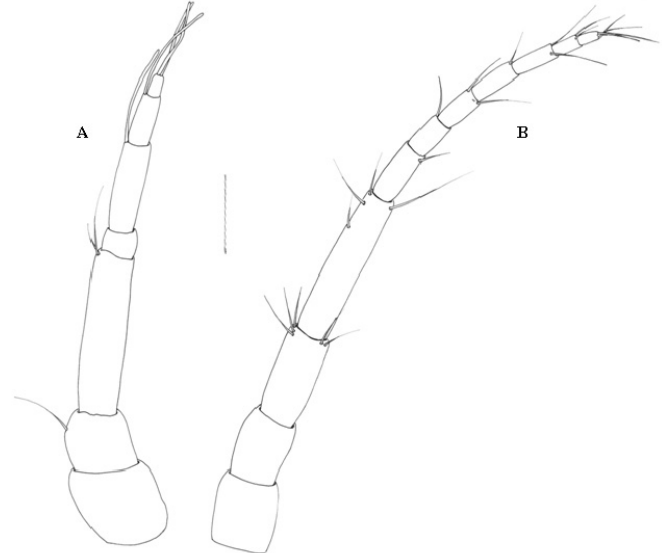
Fig. 3 – Antennae of praniza larvae collected from fishes of estuarine zone of Northeast of Pará, Brazil. A: Antennule or first antenna B: Antenna or second antenna. Bar = 30 μ